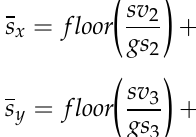
Table 1. Defined discretization parameter and distribution range of each subset. Parameter for Pattern